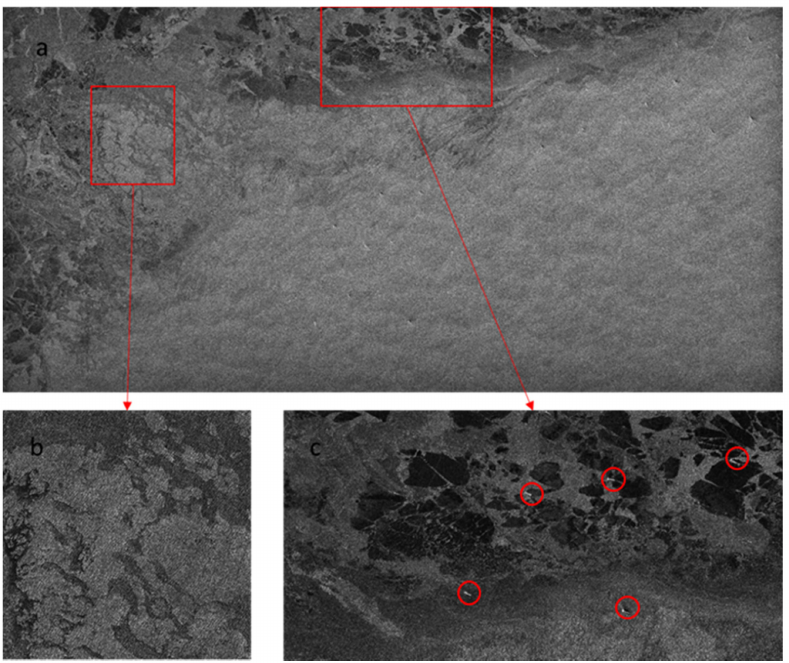
Figure 1. Sea ice image of the Bohai Sea in China obtained by HISEA-1 striping mode. ( a ) The complete obtained image whose gridding size is 31,764 × 15,668 (horizontal × vertical) and spatial resolution is 3 m; ( b ) Sea ice with a brighter view; ( c ) Sea ice with a darker view. Red circles show ships trapped in the sea